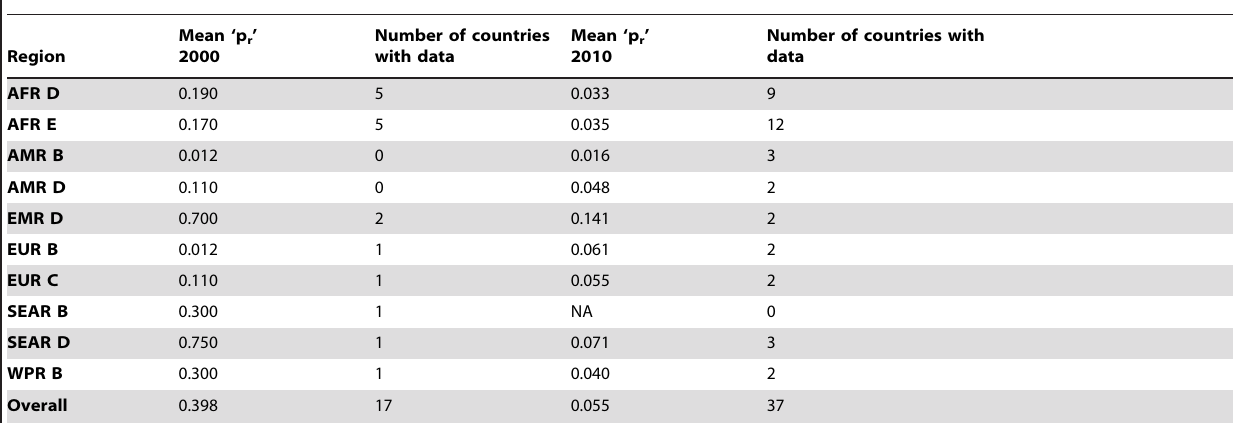
Table 3. Proportion of re-use (‘p r ’) during healthcare injections in each region, 2000 and 2010.